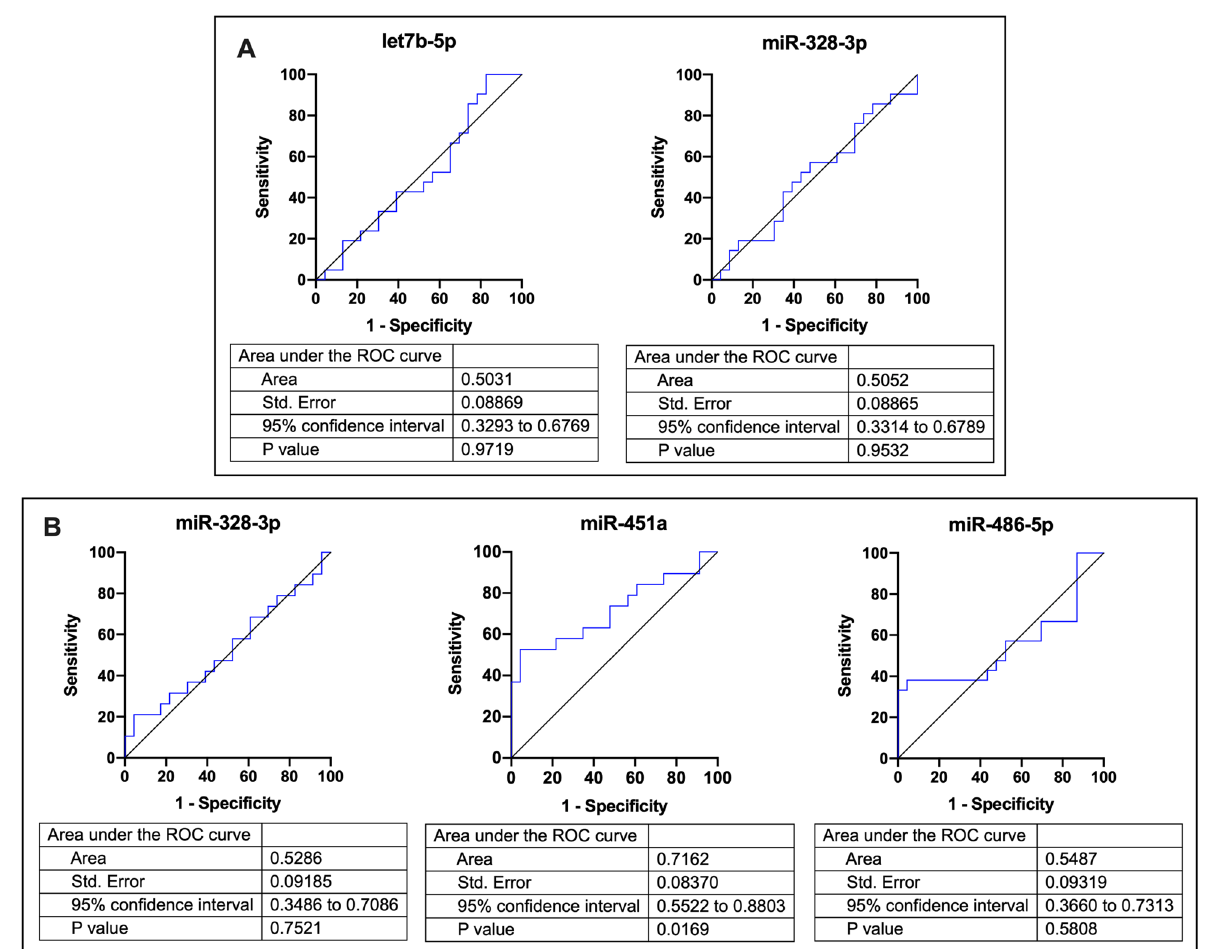
Figure 2. Predictive capacity of AF recurrence. Receiver-operating characteristic curves comparing sensitivity and specificity of ( A ) hsa-let7b and has-miR-328-3p expression in plasma from peripheral blood and ( B ) has-miR-328-3p, hsa-miR-451a, and has-miR-486-5p expression in plasma from left atrial blood, where hsa-miR-451a expression is predicting recurrence in AF patients.